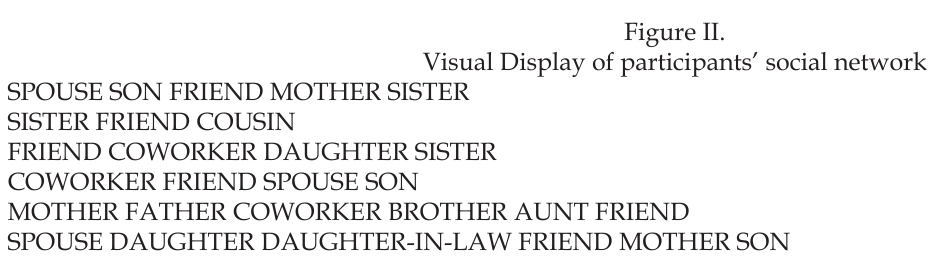
Figure II. Visual Display of participants’ social